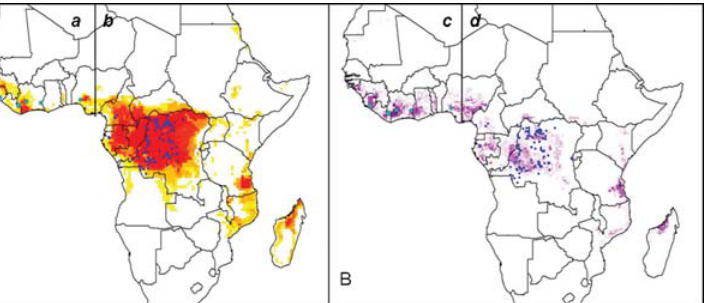
Figure 4. Ecological niche modeling results for West and Central African monkeypox. Eight West African and 146 Central African human monkeypox occurrences are indicated with green and blue circles, respectively. (A) Modeled distribution created using only Central African (blue) input data; (B) Modeled distribution created using only West African (green) input data. The vertical line (7.33 u E longitude) denotes division between West and Central Africa. Nigerian occurrences were excluded from model development. Darker shades indicate areas with greater model agreement in prediction of potential suitability for monkeypox.